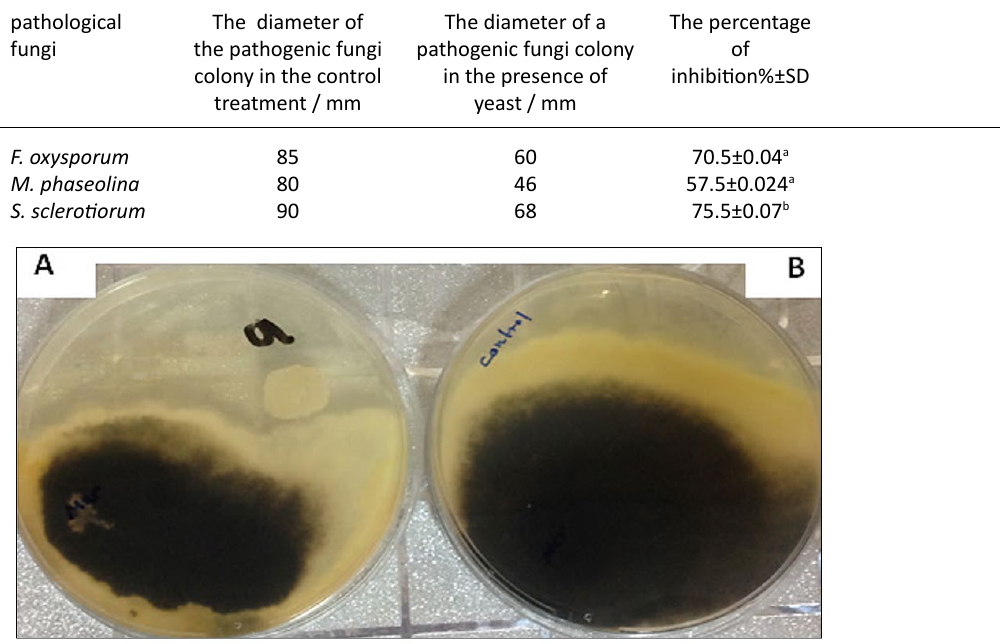
Table 3. The diameters of the pathogenic fungal colonies and control treatment, as well as the percentage of inhibition (%) for using K. marxianus yeast as a biological control agent.